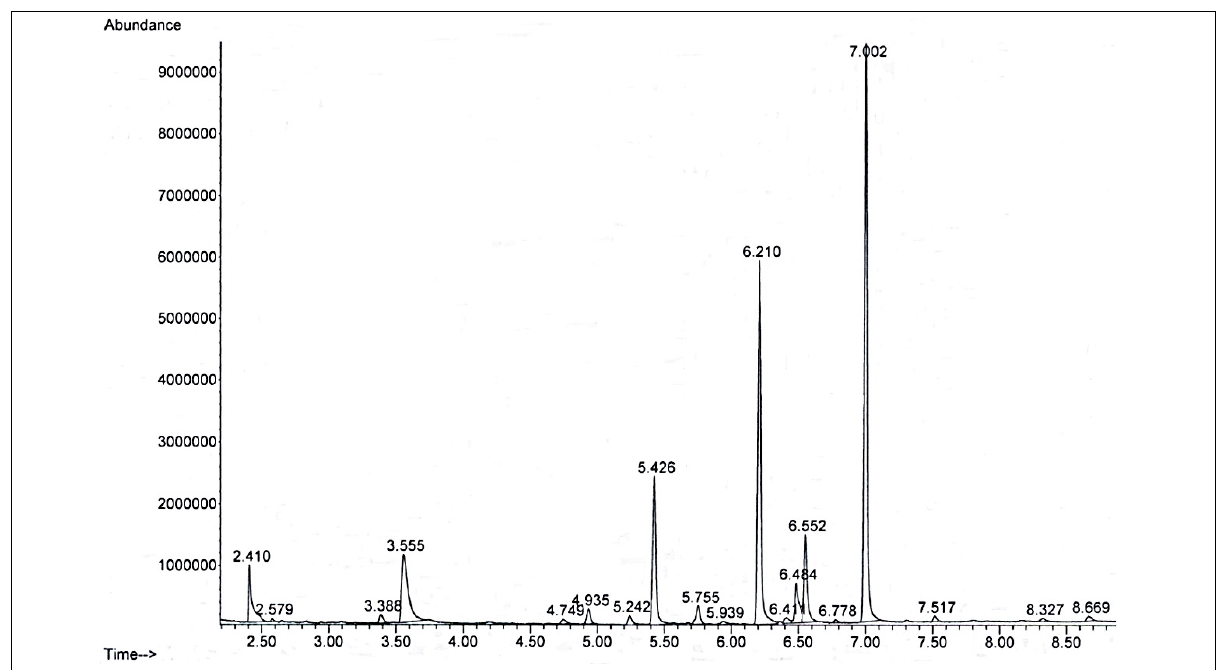
Figure 2: A typical total ion chromatograph for one of the casework samples (37959902B): (2.410) nicotine, (2.579) caryophyllene, (3.388) unknown, (3.555) caffeine, (4.749) methaqualone, (4.935) unknown, (5.242) tetrahydrocannabivarin, (5.426) tetracosane IS, (5.765) cannabidiol, (5.939) codeine, (6.210) Δ 9 -THC, (6.411) cannabigerol, (6.484) acetylcodeine, (6.552) 6-monoacetylmorphine, (7.002) diamorphine, (7.517) nonacosane, (8.327) unknown, (8.669) vitamin